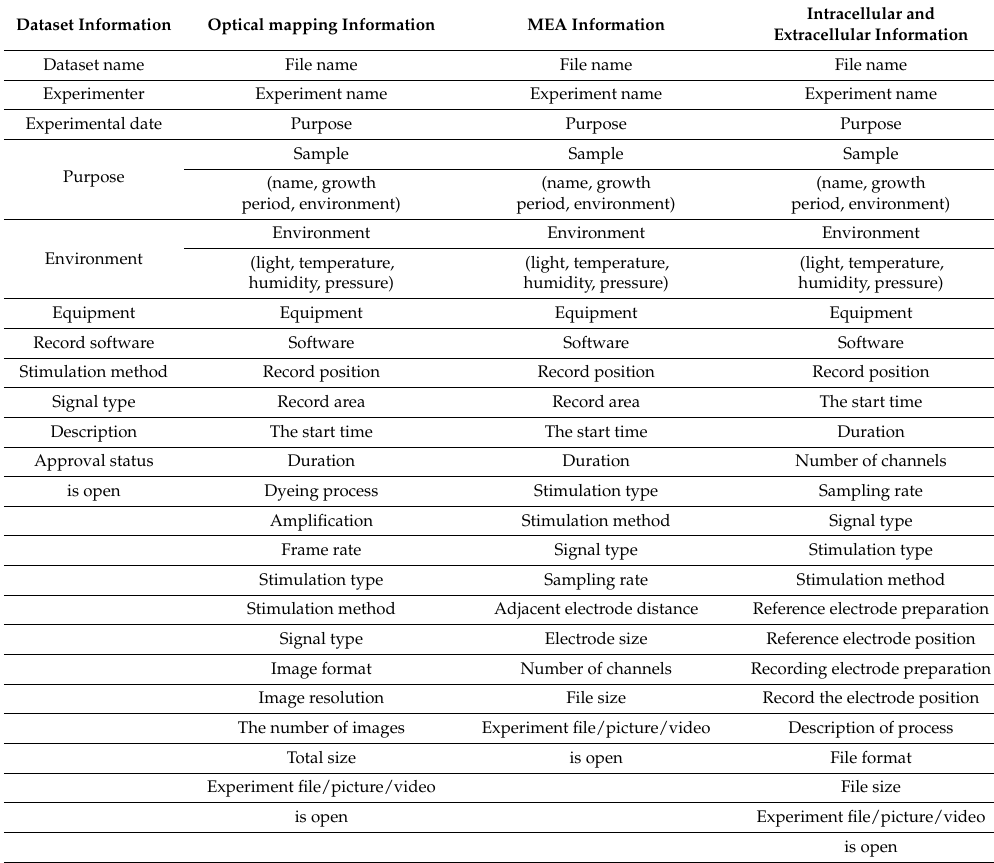
Table 3. The Information of Metadata (An example